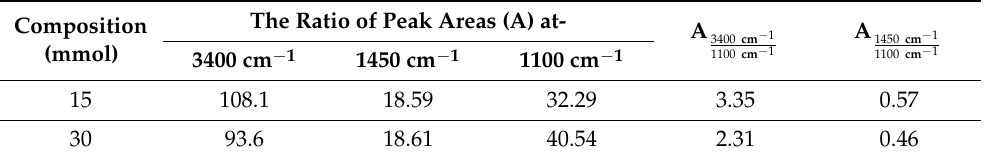
Table 4. The ratio of peak areas of O-H to Si-O-Si at 3400 and 1100 cm − 1 and the C-H to Si-O-Si vibration at 1450 and 1100 cm − 1 from the FTIR spectra of SiO 2 -TiO 2 -OTMS samples with various compositions of